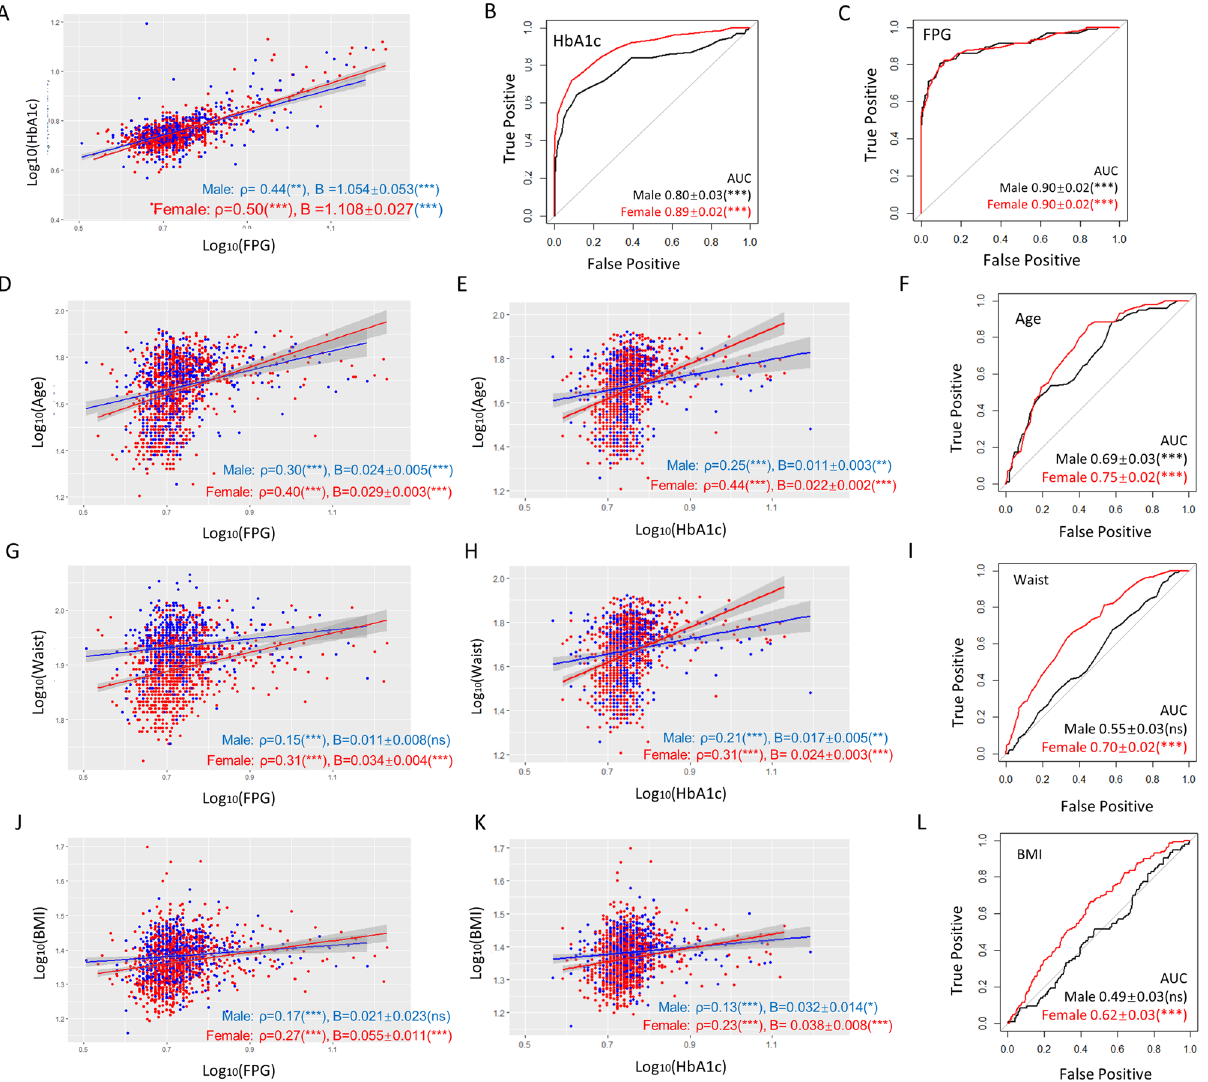
Figure 1. HbA1c, Age, waist circumference and BMI predict T2D better in women than in men. ( A ) Comparisons of association and linear regression of HbAc1 to FPG in women and men. Spearman’s association coefficient (ρ) indicates a tighter association in women. Linear regression coefficient ( B ) indicates a stronger influence of HbA1c on FPG levels in women. P values, regression constant can be found in Tables S2 and S3. ( B ) HbA1c is a better T2D predictor in women. Receiver operating characteristic (ROC) was plotted for HbA1c and T2D and area under the curve (AUC) is indicated. ( C ) ROC-AUC analysis shows no sex-difference of FPG in predicting T2D. ( D , E ) Age has a tighter association (Spearman’s ρ) with and stronger influence (steeper slope) on FPG and HbA1c in women. ( F ) Age is a stronger T2D predictor for women (higher ROC-AUC values). ( G , H ) Waist circumference has a tighter association with and stronger influence on FPG and HbA1c in women. ( I ) Waist circumference is a stronger T2D predictor for women as judged by ROC-AUC. ( J , K ) BMI has a tighter association with and stronger influence on FPG and HbA1c in women. ( L ) BMI predicts T2D in women but not men as judged by ROC-AUC analysis. AUC area under the curve, ns not significant, *P < 0.05, **P < 0.01, ***P < (Table S2). Except for HDL, the slopes of linear regression were steeper in women than in men, suggesting that changes in these lipid profiles affect FPG and HbA1c stronger in women than in men (Fig. 3). All triglyceride levels, total cholesterol, LDL and HDL predicted T2D better in women than in men: the ROC-AUC values were 0.66 ± 0.03 (P < 0.001) vs 0.58 ± 0.03 (P < 0.05) by triglyceride, 0.63 ± 0.03 (P < 0.001) vs 0.53 ± 0.03 (ns), by total cholesterol, 0.62 ± 0.03 (P < 0.001) vs 0.52 ± 0.03 (P < 0.01) by LDL and 0.58 ± 0.03 (P < 0.01) vs 0.50 ± 0.03 (ns) by HDL (Fig. 3C,F,I,L). Significantly, binary logistic regression modeling suggested that except for HDL, increases in these lipid parameters were associated with T2D in women but not in men (Table 1). These remained true after adjustment for age, smoking, overweight, hyperlipidemia, hyperuricemia, and T2D. HDL was negatively associated with T2D and interestingly, women were benefited more than men by